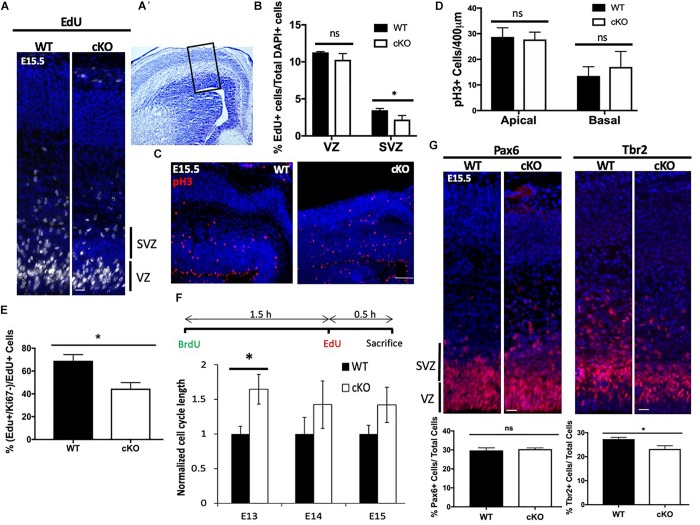
Altered cell cycle kinetics within Snf2h cKO neural progenitors. (A) Representative immunofluorescent images of DAPI stained nuclei (blue) and 2 h. EdU pulse-labeled cells (white) at E15.5. (A’) Cresyl violet stained coronal section indicating the region shown in the fluorescent images. The black box highlights the regions used for quantitation. (B) Quantitation of the proportion of EdU+ cells within the VZ and SVZ at E15.5 following a 2 h. pulse. (C) Representative images of phospho-Histone H3+ (pH3) mitotic cells (red) within the E15.5 neocortex of WT and Snf2h cKO mice. Sections were counterstained with DAPI (blue). (D) Quantitation of the proportion of pH3+ cells at the apical surface or located basally at E15.5. (E) EdU and Ki67 double-labeling experiments were quantitated to determine the proportion of cells that exited the cell cycle 24 h later (EdU+ and Ki67– cells/EdU+ cells). (F) BrdU and EdU double-labeling experiments were used to estimate cell cycle length. Schematic shows the timing of BrdU and EdU injections. The mathematical formulas used to determine cell cycle length are provided in the Section “Materials and Methods.” Cell cycle length was normalized to WT cell cycle length and compared at three time points: E13, E14, and E15. (G) Representative images of RG (Pax6+) and IPCs (Tbr2+) immunostaining at E15.5 in WT and Snf2h cKO neocortex. Quantitation shown below the images indicates a reduction in IPCs but not in RG in mutant samples relative to controls. Values in all graphs are presented as the mean ± SEM; n = 4 mice per genotype; Student’s t-test, ∗P < 0.05, ns = not significant. Scale bars (A,G) 20 μm; (C) 50 μm. P < 0.05, ns, not significant. Scale bar in (A,C,G) are 20, 50, and 20 μm, respectively.